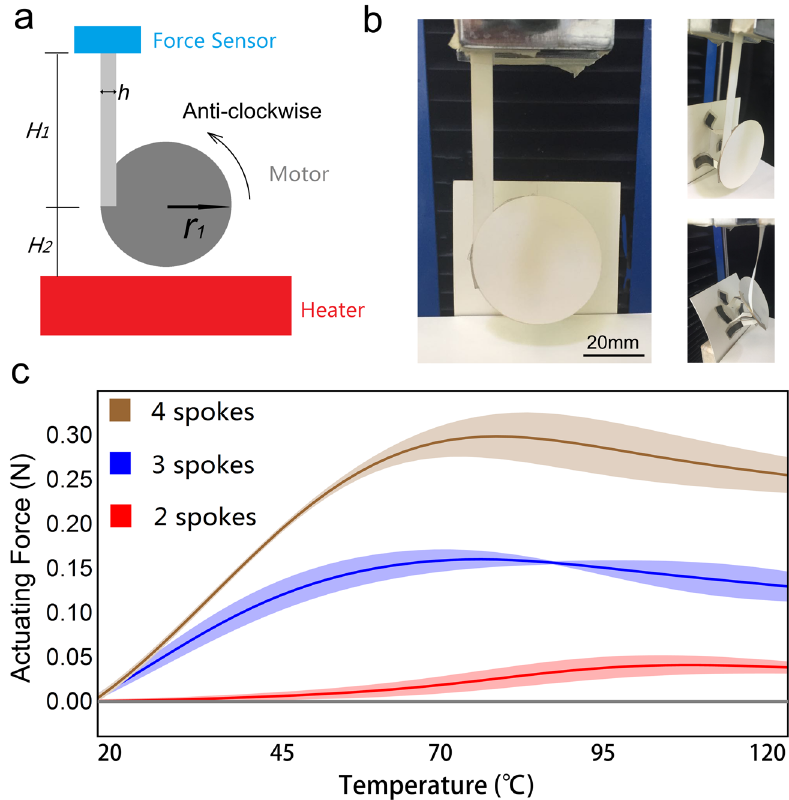
Figure 4: ( a ) Experimental scheme to measure the actuating forces of the heat - driven motors, where = H and = r 20 mm 1 . ( b ) Experimental photographs. ( c ) Actuating force as a function of temperature with two ( red ) , three ( blue ) , and four ( brown ) spokes. The size of each spoke is × 6 mm 25 mm . For each experimental result with an individual color, the central curve shows the average of three measurements, and the region contains the measured